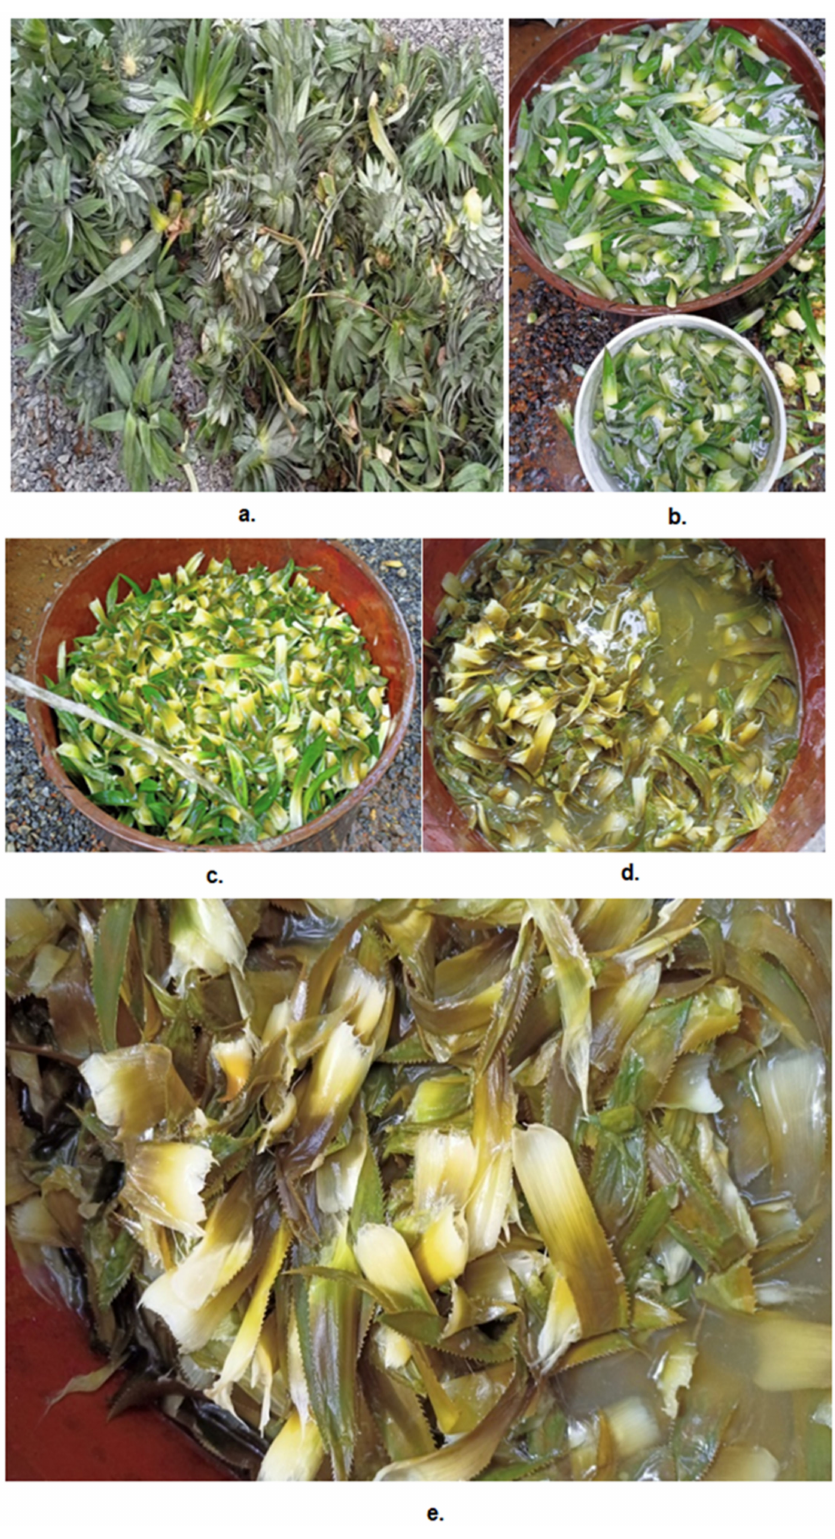
Figure 1. ( a ) Cluster of pineapple crown leaves (PCLs) removed from pineapple head; ( b ) PCLs immersed into basin; ( c ) water replacement after 5 days; ( d ) PCLs after 20 days; ( e ) PCLs after 20 days with water removed, ready for fiber